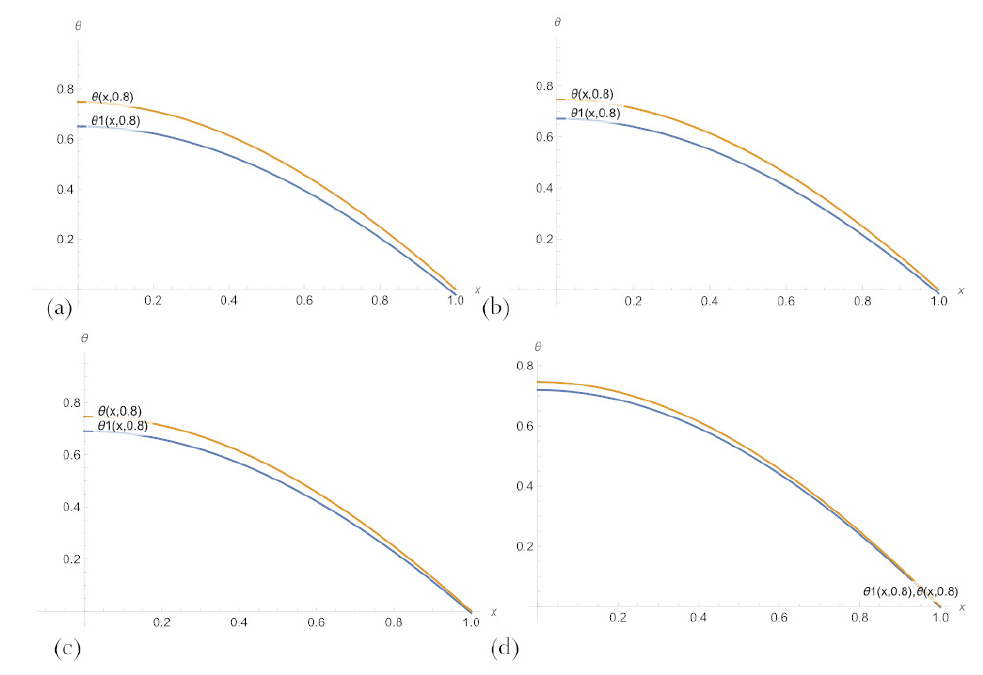
Figure 9. A comparison of PBA-PINN (20) for ( a ) n = 3 and ( b ) n = 10, ( c ) PBA-PINN (23) for n = 3, N = 1, and ( d ) classical PINN with n = 20 neurons of a hidden layer and activation function (18), after learning by minimising the loss (21), and an exact solution to the problem (11) for δ =